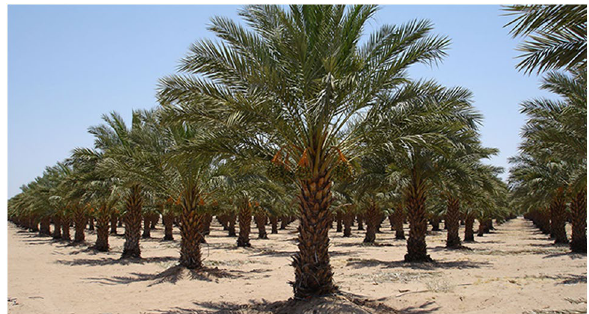
Fig. 1 Date palm plantation Source : islam